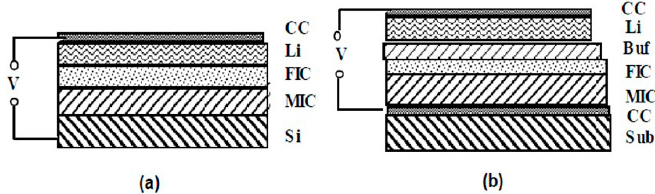
Figure 1. Design principles for lithium microbatteries composed of a lithium film (Li), fast-ion conductor (FIC), mixed ionic-electronic conductor (MIC), current collector(s) (CC), silicon substrate (Si), glass substrate (Sub), and buffer layer (Buf). ( a ) four-layer design on a conducting substrate and ( b ) six-layer stack incorporating two metallic current collectors (Reproduced with permission from [25]. Copyright 2000 Springer).